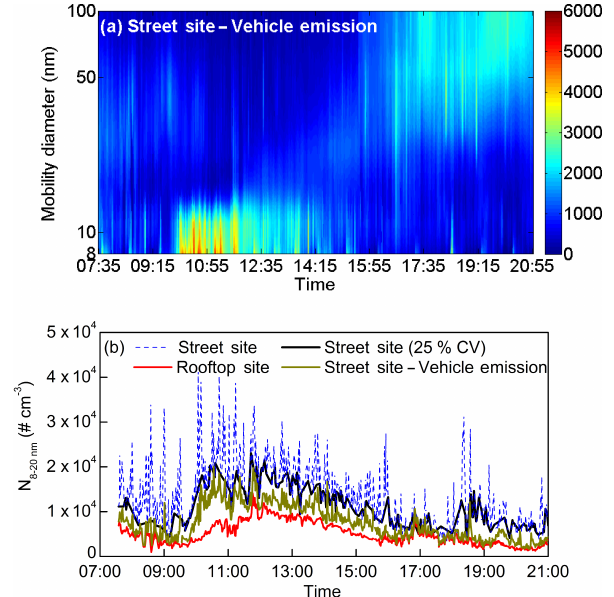
Figure 6. Contour plot and time series of particle number concen- tration with two approaches used to deduct freshly emitted traffic particles on 22 December 2011 ( a contour plot of particle number concentration calculated from the second approach described in the Supplement; b time series of number concentration at the street and rooftop site and those calculated from the two approaches defined in the text).